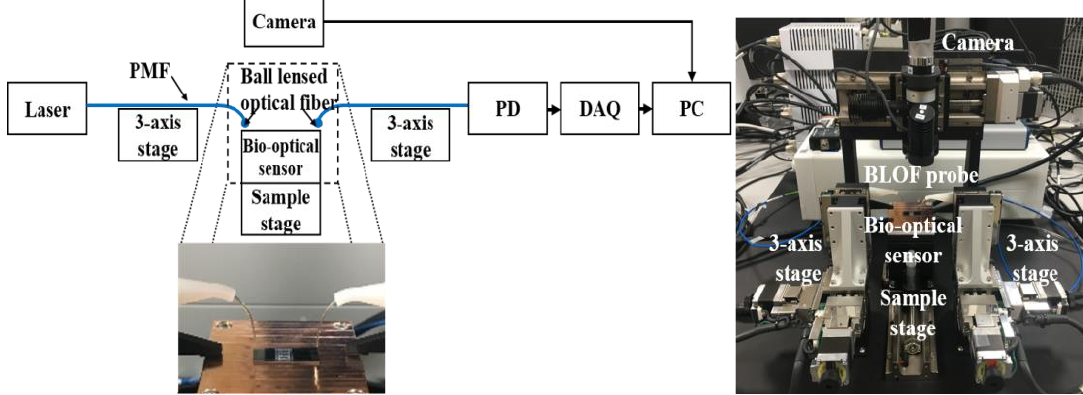
Figure 1. Schematic diagram and photograph of the BLOF based bio-optical signal sensing and measurement